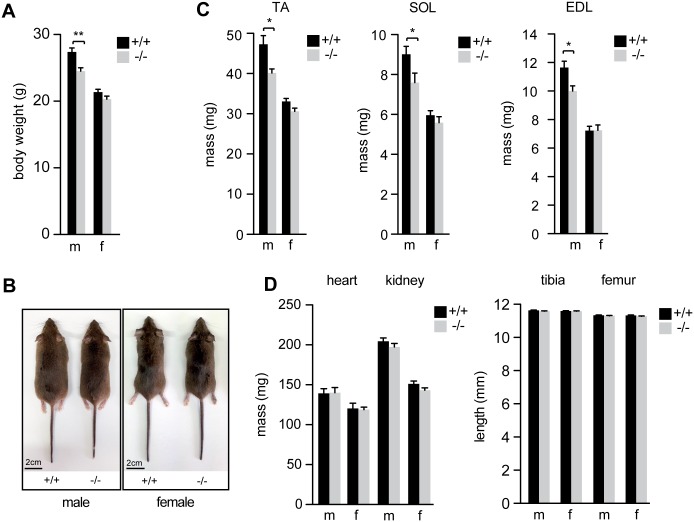
Phenotype of 12 week old SynB-/- and WT mice.(A) Body weight. (B) Representative WT and SynB-/- male (m) and female (f) mice. (C) Muscle mass of three skeletal muscles located in the hindlimb, TA (Tibialis Anterior), SOL (Soleus), EDL (Extensor Digitorum Longus). (D) Mass of heart and kidney, length of tibia and femur. Data are the mean ± SEM (number of mice per sex and per genotype: 13–17 in A, 5–11 in C, 4–7 in D; * p<0.05, ** p<0.01, Mann and Whitney test).